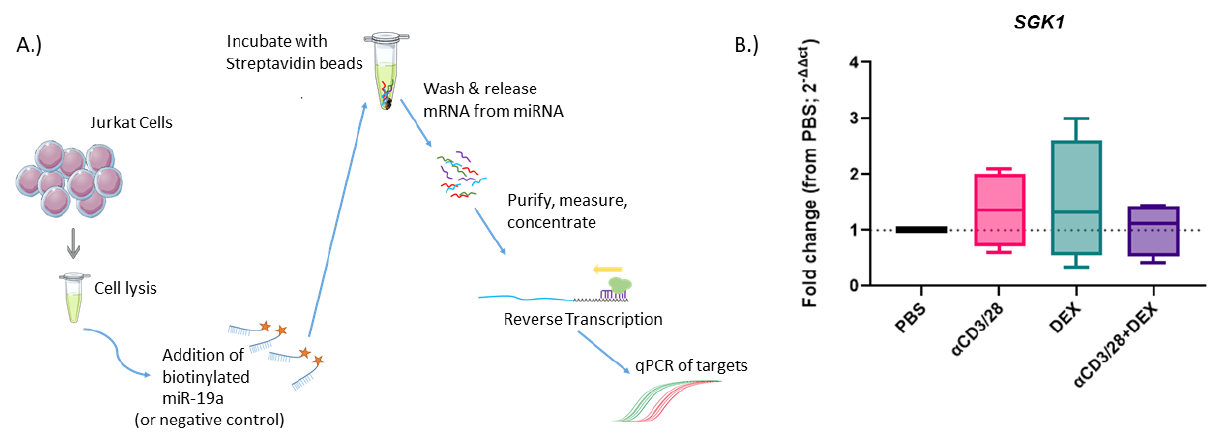
Figure 5. miR-19a directly binds SGK1. Biotinylated miR-19a was used to directly pull out SGK1 from Jurkat cell lysates. ( A ) Graphical representation of the pulldown protocol. ( B ) SGK1 mRNA binding was examined after pulldown by miR-19a. Results are shown as fold change from PBS (2 − ∆∆ CT ); α CD3 α CD28 ( α CD3/28), dexamethasone (DEX), α CD3 α CD28 and dexamethasone ( α CD3/28 + DEX) or media alone (PBS vehicle).